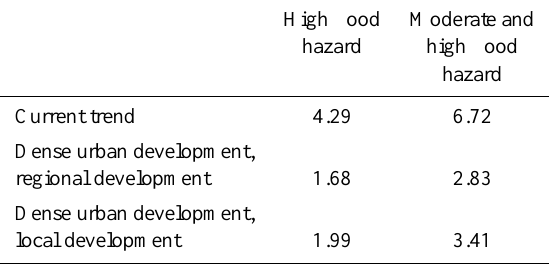
Table 5. Influence of the degree of restriction on future development in flood-prone areas using the present-day flood hazard map on the decrease in flood damage in the 19 municipalities for the wet climate scenario. Values are the damage decrease (%) compared to the non-consideration of the flood hazard